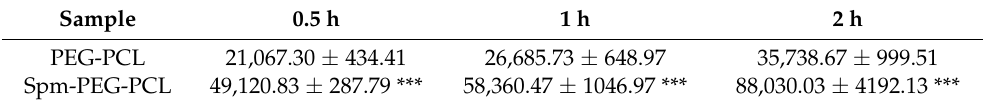
Table 4. Flow cytometry data for the efficiency of micelle uptake (mean ± standard deviation, n =